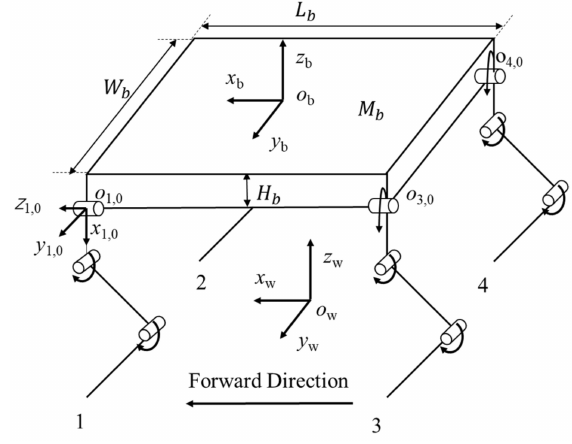
Figure 1. Billy robot dog simplified structural model.